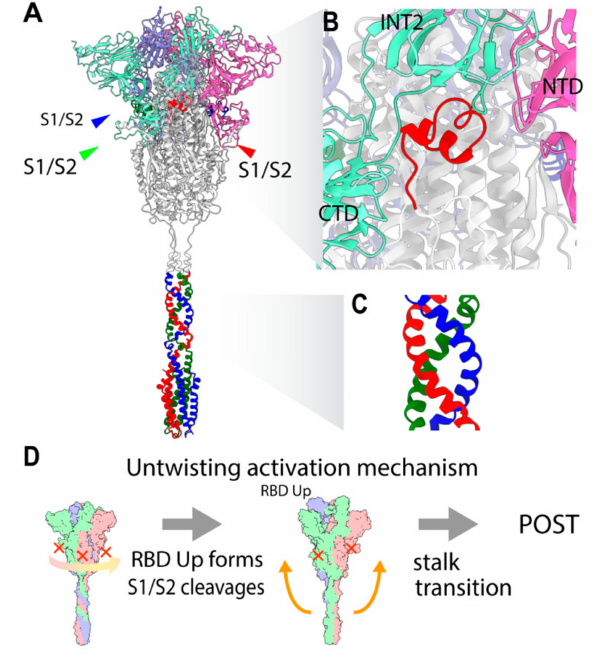
Figure 2. Structural characteristics of the PRE state and untwisting activation mechanism. ( A ) Overview of PRE state structure. The S1 subunits and stalk are colored with light RGB and RGB, respectively. A CL segment is colored in red. ( B ) A close-up of the CL switch (red). CL is making contact with adjacent S1 (light green) while having space with an intra-monomer NTD (light red). CL is disordered in many PRE structures. ( C ) A close-up of the stalk. ( D ) Schematic figure of the untwisting activation mechanism for the transition toward the POST state. The conditions for the transition are three S1/S2 cleavages and three RBD Up